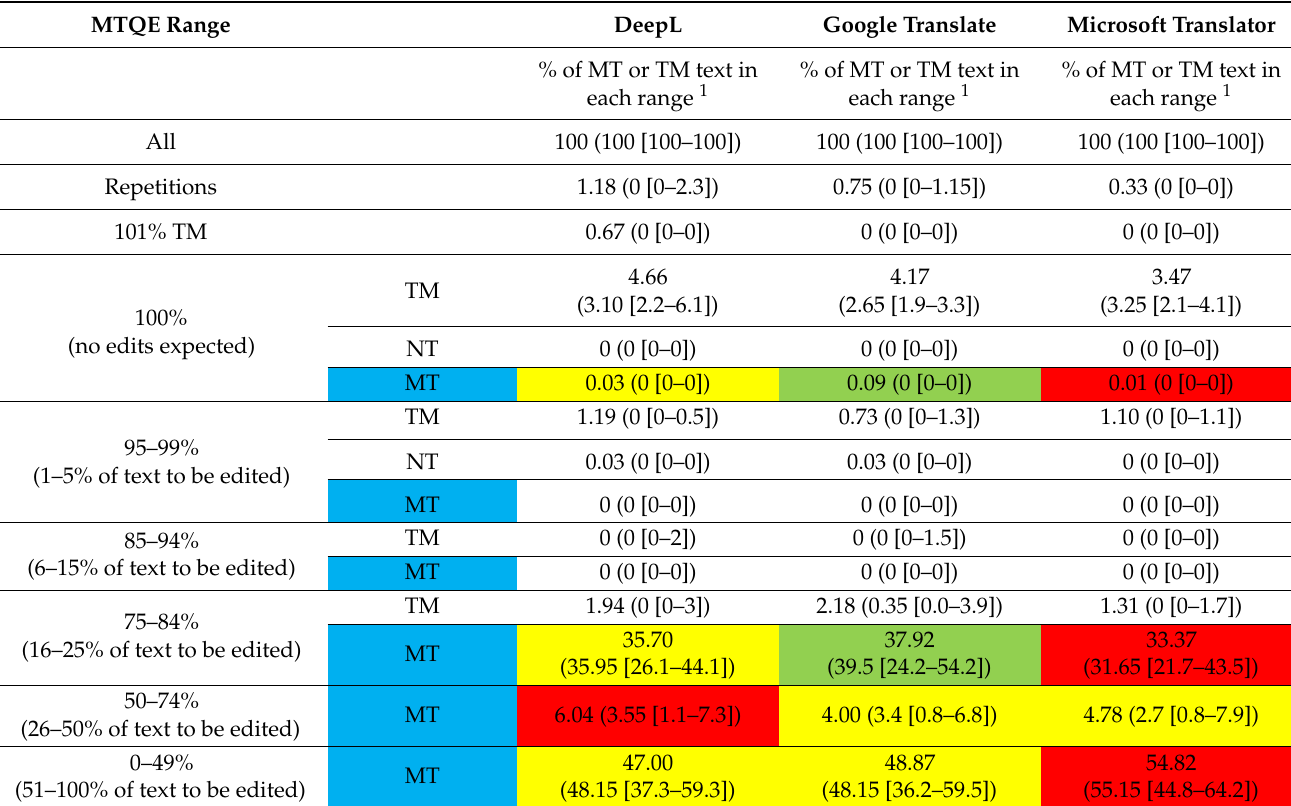
Table 2. Results of Default analysis per MTE—the average percentages of machine translation (MT) and translation memories (TM) per estimated quality range. TM matches are included in the table for completeness, but they were not relevant for our